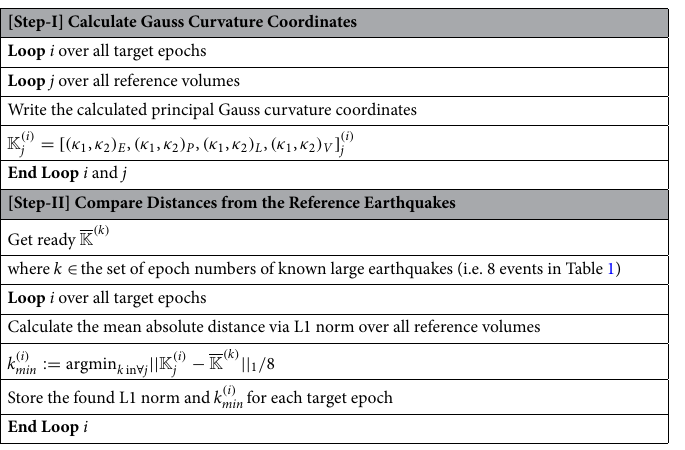
Table 3. Algorithm—Searching the closest large earthquake using Gauss curvature